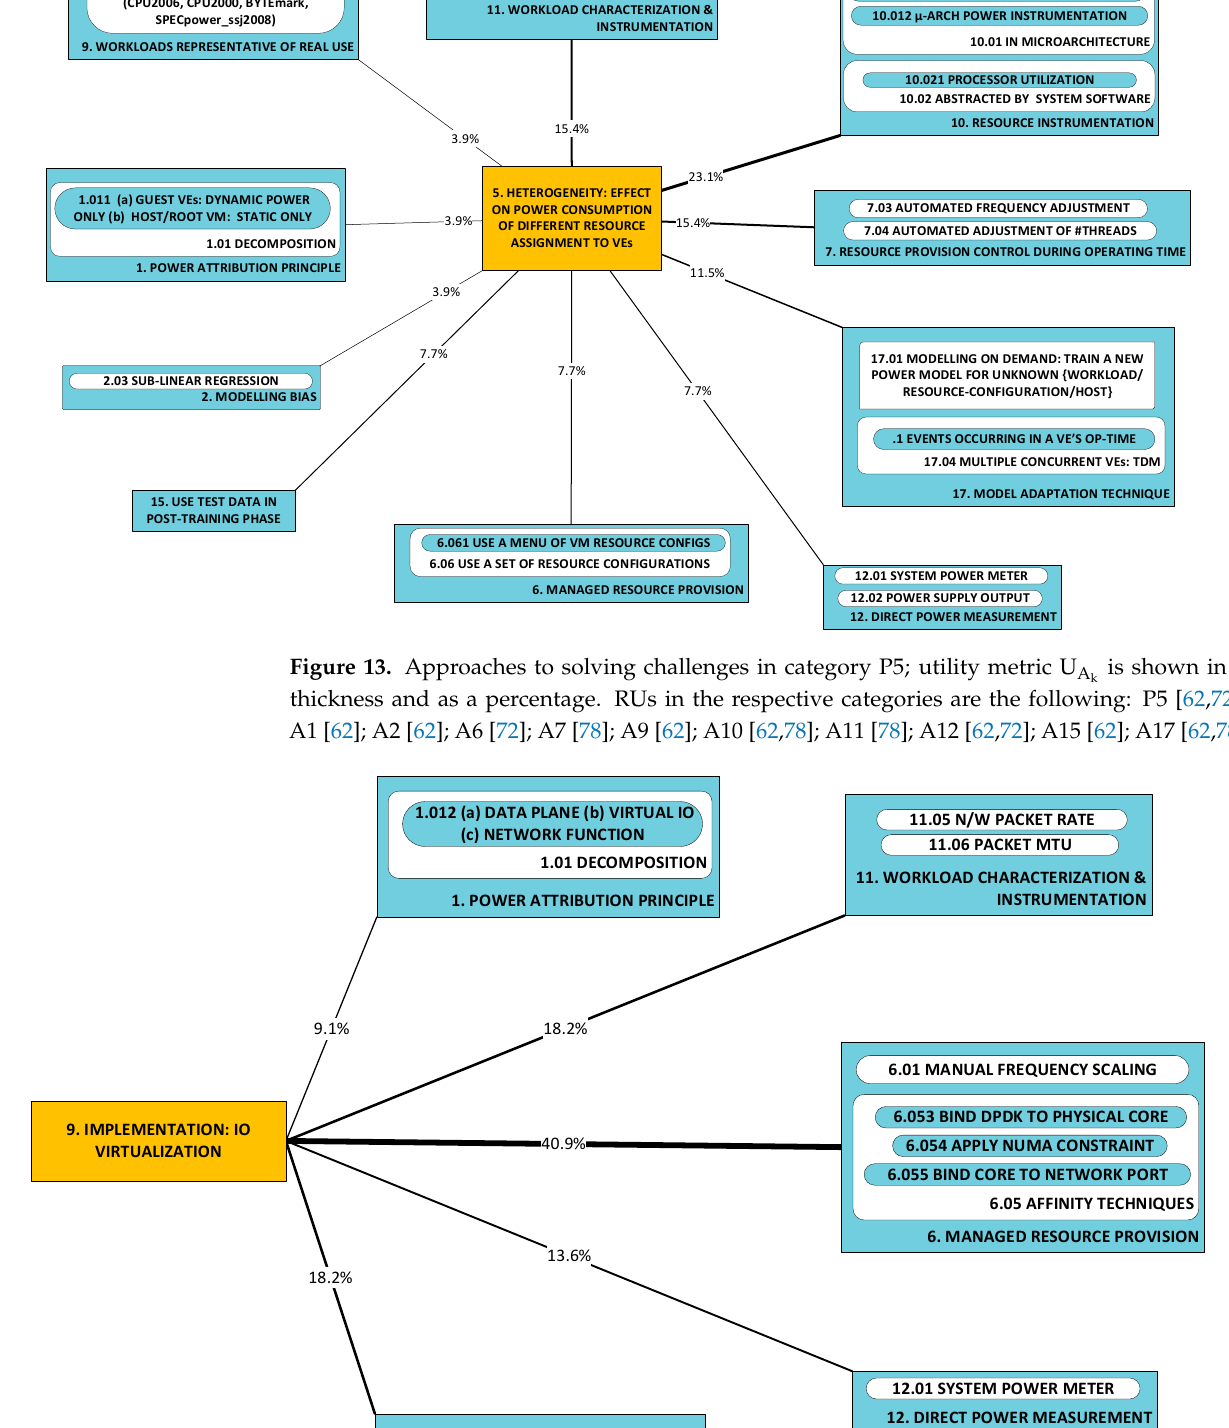
is shown in line is shown in line (cid:3169) k